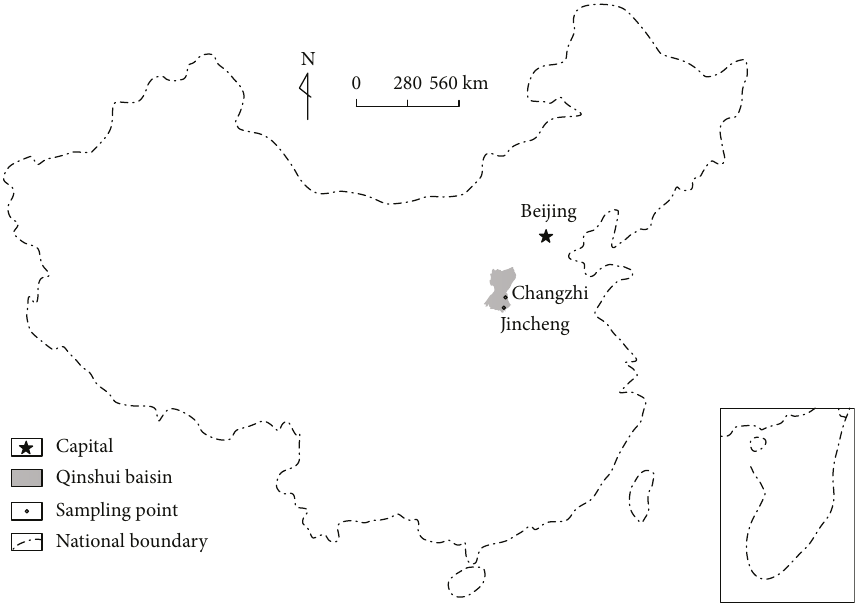
Figure 1: Location of coal specimens studied in this paper. Table 1: Results of vitrinite re fl ectance and proximate